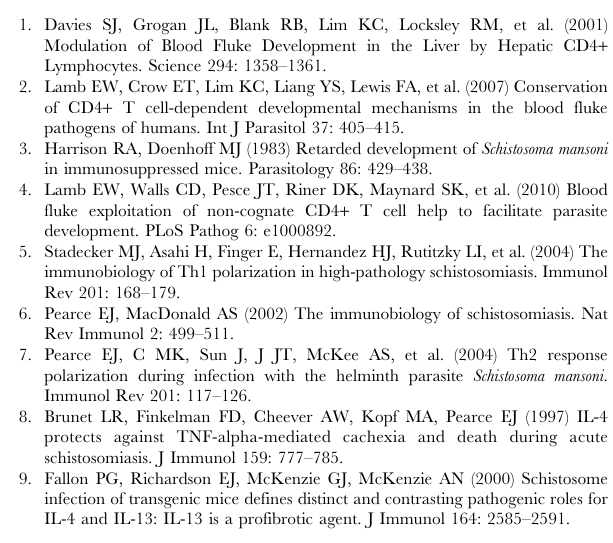
Figure S1 Acetaminophen (AAP) and D-galactosamine (GalN) induce liver necrosis and inflammation in RAG 2 / 2 mice. Representative H&E-stained liver sections from RAG 2 / 2 mice treated throughout pre-patent infection with acetaminophen (A) or D-galactosamine (B). Arrowheads indicate areas of necrosis. Arrows indicate infiltrating inflammatory cells. Scale bars in A and B are 300 m m in length. Figure S2 Regulation of pro-inflammatory cytokine transcription requires repeated administration of MSU. Groups of S. mansoni -infected RAG 2 / 2 mice were either repeatedly treated with MSU throughout pre-patent infection, until 6 weeks p.i., and were euthanized 18 hours after the last dose of MSU (A–C), as described in Materials and Methods, or received a single 500 m g dose of MSU 18 hours prior to euthanasia (D–F). At euthanasia, livers were removed for analysis of IL-1 a (A, D), IL- 1 b (B, E) and CCL2 (C, F) mRNA content by real-time PCR. Horizontal bars represent mean values for each experimental group. P values were calculated using the Mann Whitney test.